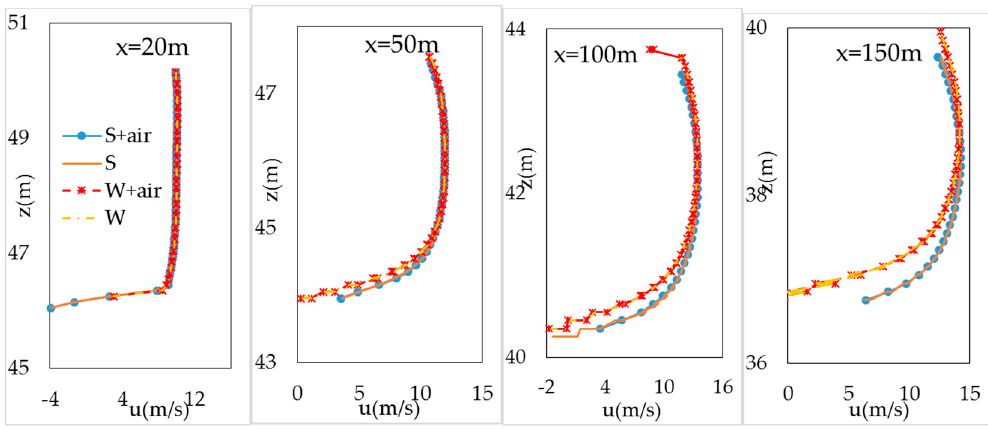
Figure 19. u-velocity estimated with and without air entrainment model for cases with wall and step abutments when Z up = 55.86 m.